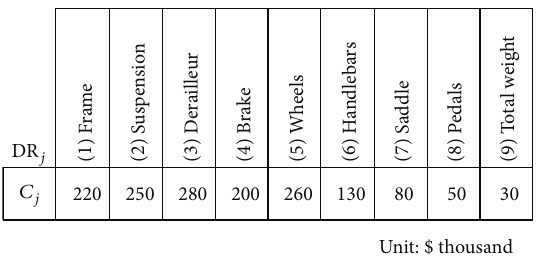
Figure 7: Completely fulfilled design cost 𝐶 𝑗 for DR 𝑗 .